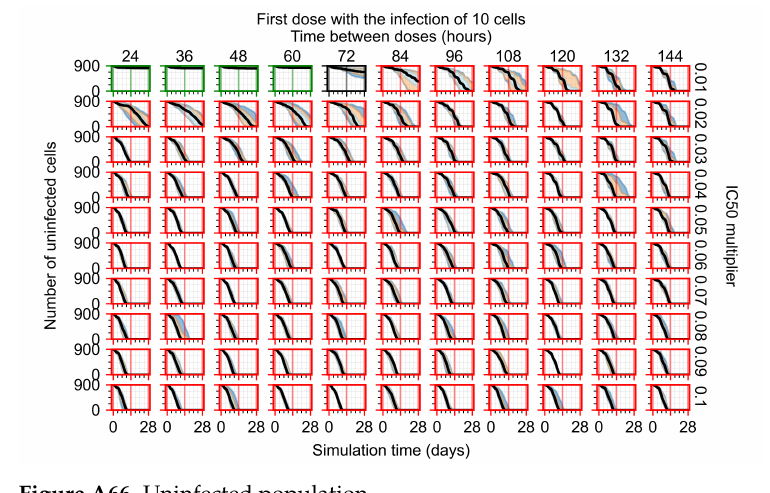
Figure A66. Uninfected population.